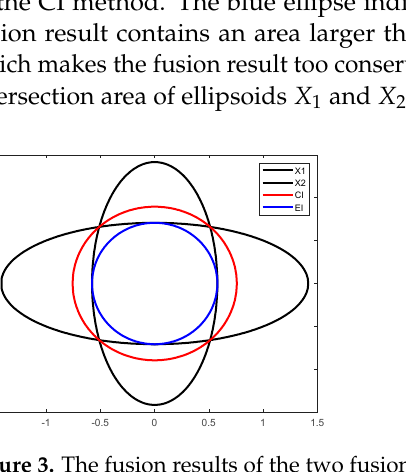
Figure 3. The fusion results of the two fusion methods for ellipsoids X 1 and X 2